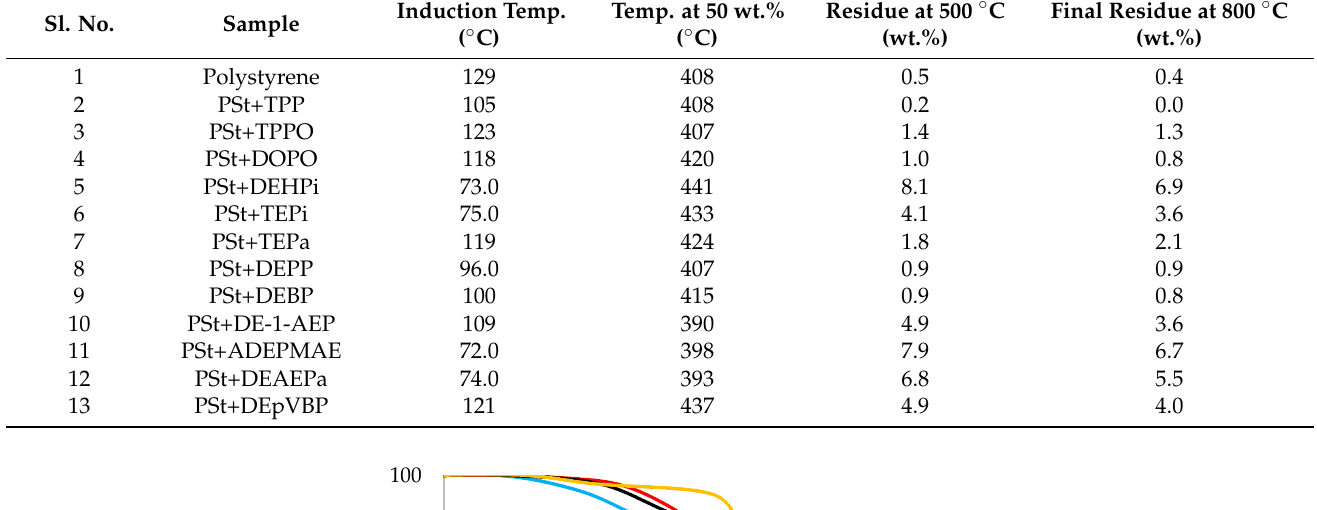
Table 2. Some relevant parameters from the TGA analyses carried out in nitrogen at a heating rate of 10 ◦ C min − 1 of PSt-based systems.